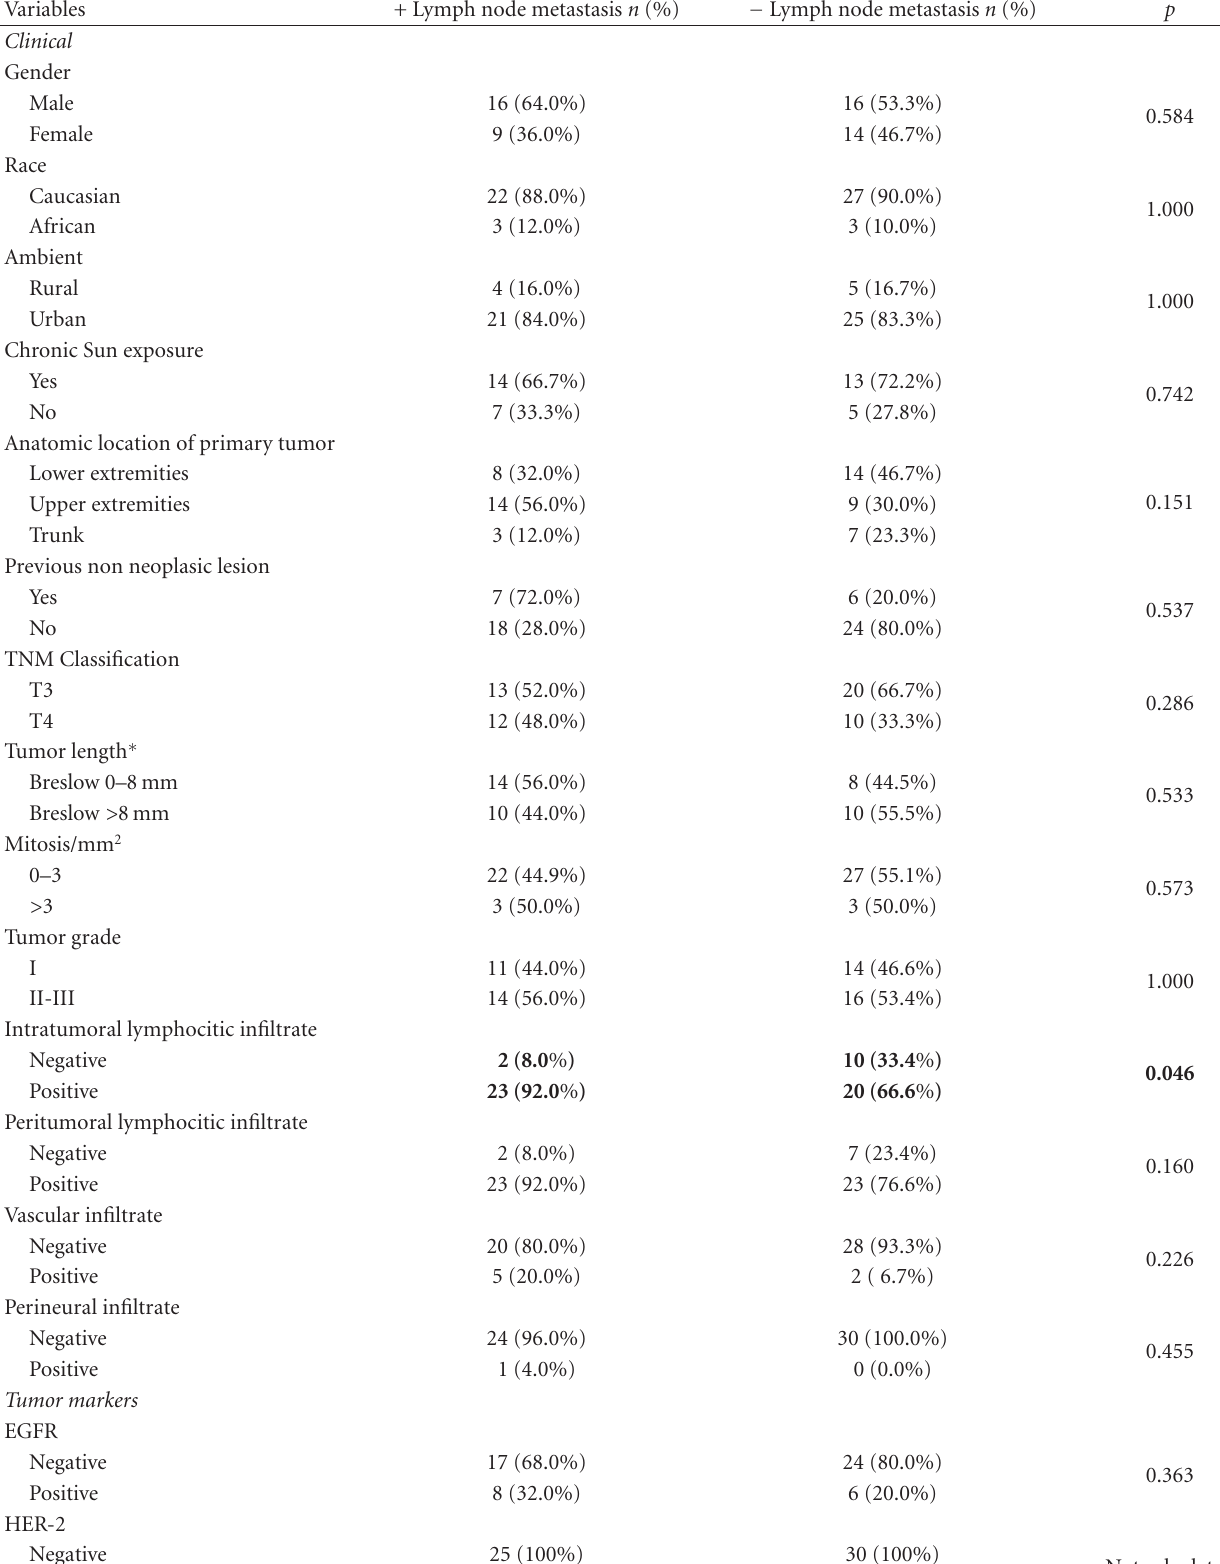
Table 2: Univariate analysis of risk factors for lymph node metastasis in patients with locally advanced cutaneous squamous cell carcinoma of trunk and